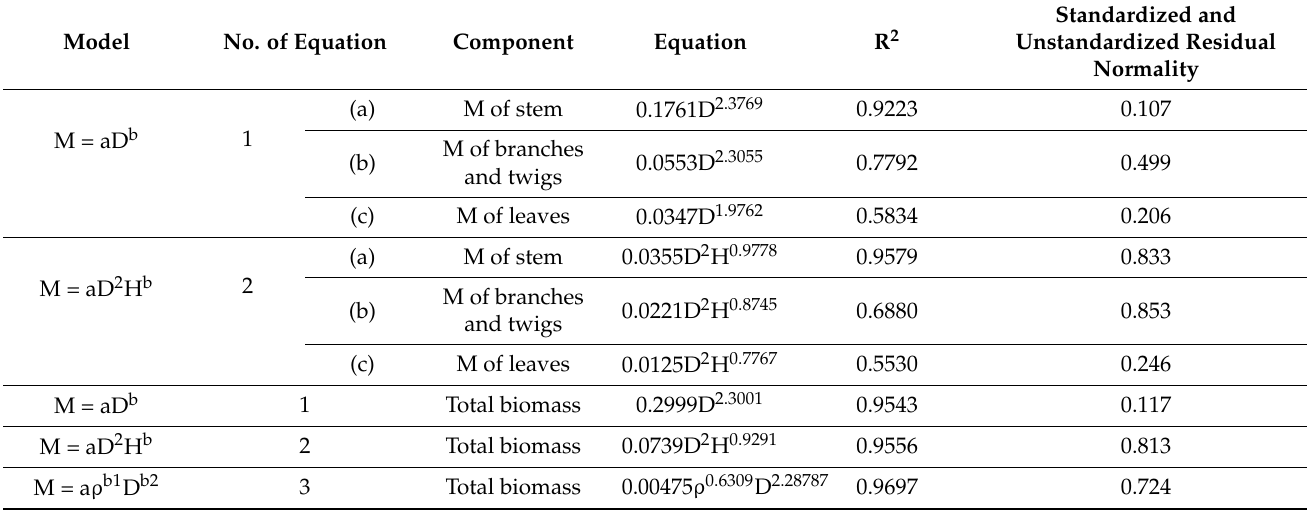
Table 2. Summary of the allometric equation derived from 15 destructive samples using diameter at breast height, stem height, and wood density